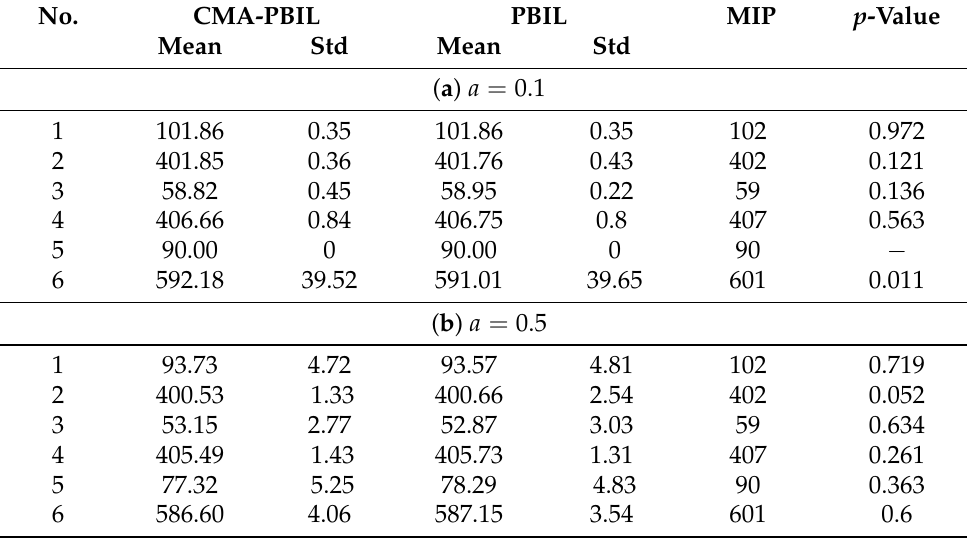
Table 3. Comparison of mean values and standard deviations of the objective function for each test case.